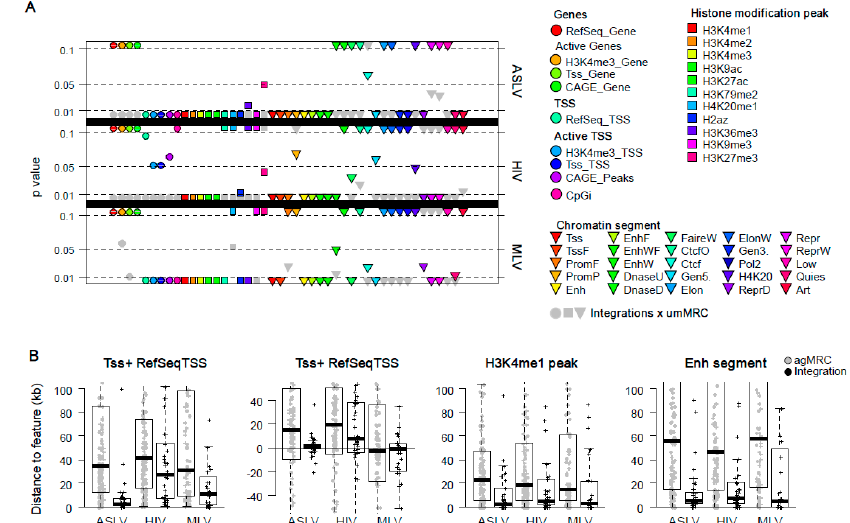
Figure 6. Comparison of integration sites of stable active proviruses and respective active gene-matched random controls. ( A ) Statistical p -values of differences between agMRC and integration sites are represented by coloured circles (genes), squares (peaks of histone modifications) and triangles (chromatin segments) and aligned with x axis. agMRCs are created to match the proviral integration sites with the frequency of targeting RefSeq Genes with active TSS part according to the chromatin segment classification. Thin dashed lines mark the p -values of 0.01, 0.05 and 0.1. Values outside the range from 0.01 to 0.1 are located at the lower/upper edge of the chart beyond the dashed lines. Grey symbols represent the p -values of testing integration sites against umMRC. ( B ) Examples of the charts representing the values of agMRCs and proviral integration sites. From left to right: Tss + RefSeqTSS, absolute distance; Tss + RefSeqTSS, distribution around TSS; peaks of H3K4me1 enrichment; enhancer segments.